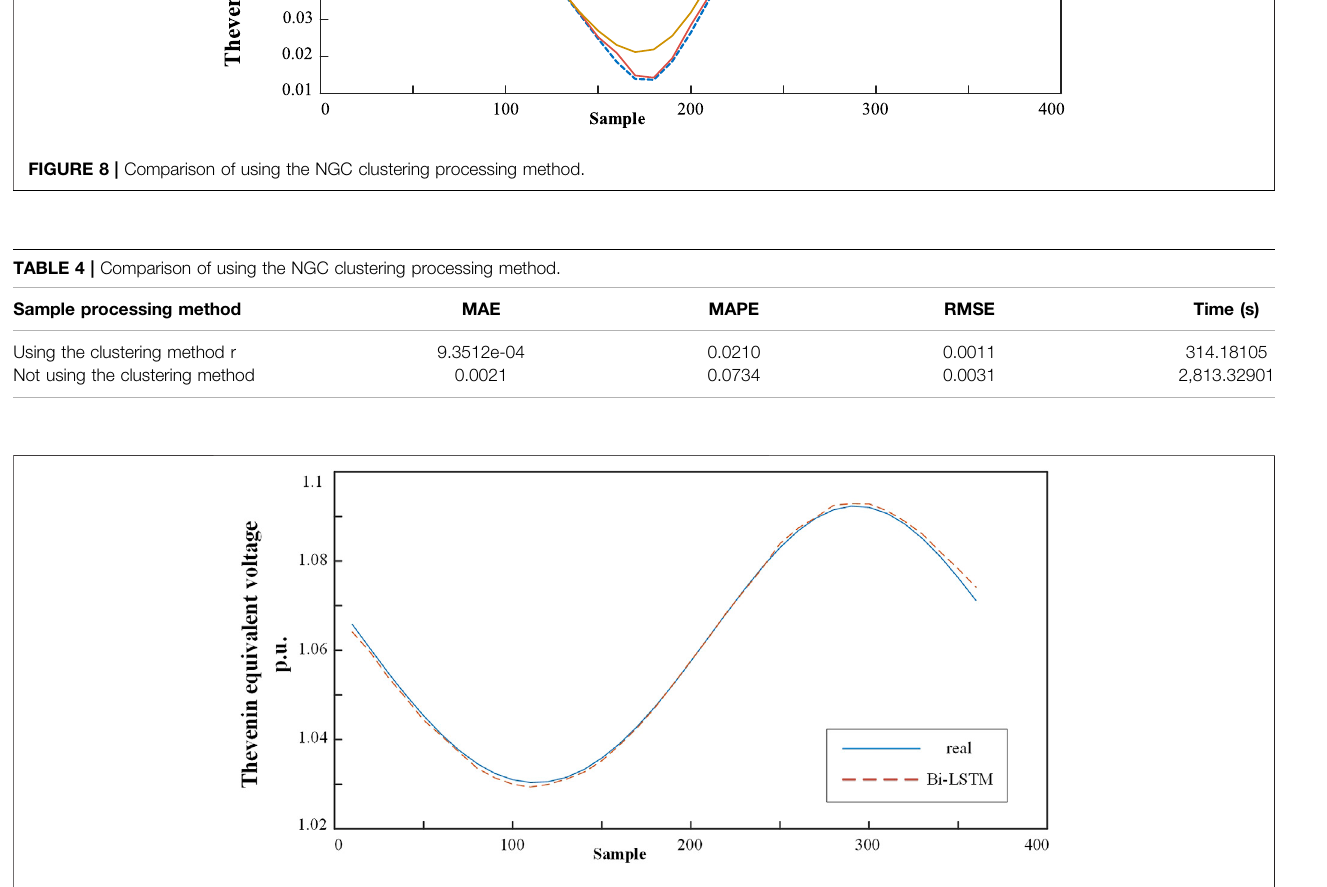
FIGURE 9 | Results of Thevenin equivalent voltage compared to the real